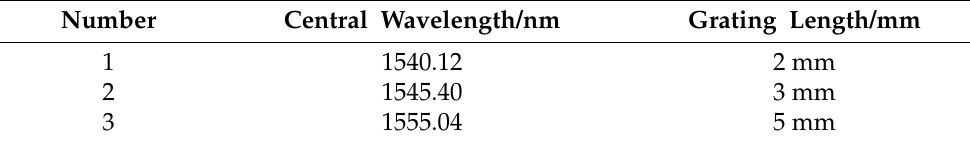
Table 1. Relevant parameters of FBG